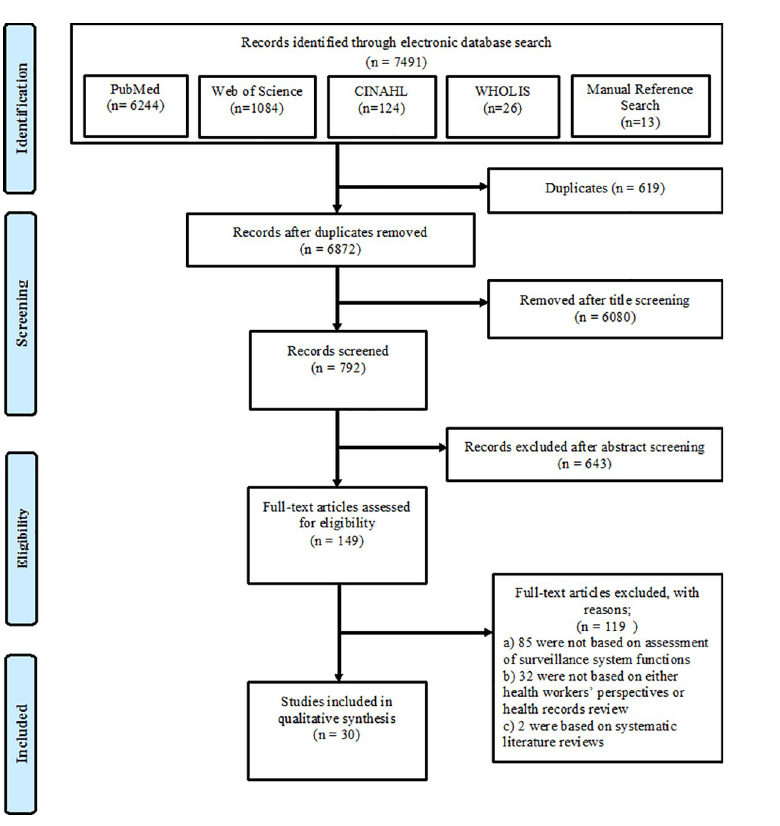
Fig 1. Flow chart summarising the systematic review